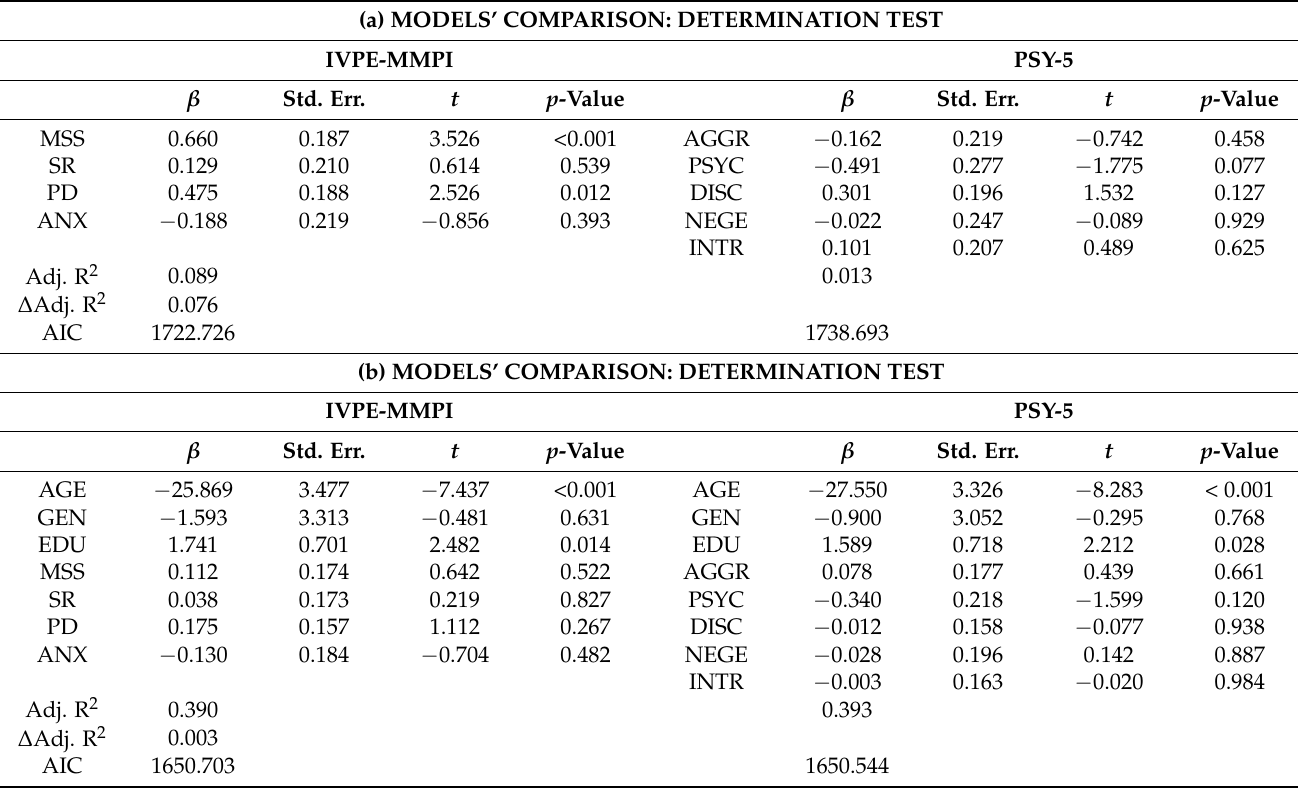
Table 1. Standardized beta coefficients. Standard errors and significance levels for predictors of the Determination Test (DT) variable. Adjusted R 2 and Akaike Information Criterion (AIC) are also reported. Comparisons between models are presented uncontrolling for demographics ( a ) and considering their contribution ( b